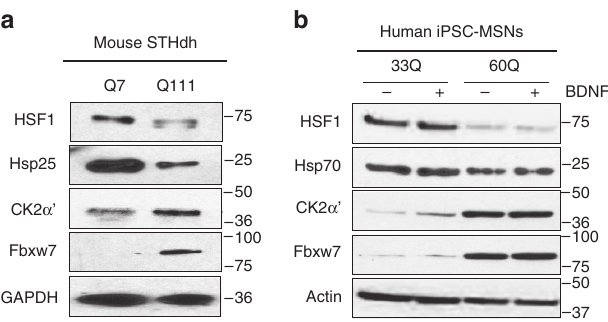
Figure 6 | Decreased abundance of HSF1 and increased levels of CK2 a 0 and Fbxw7 in mouse striatal neurons and differentiated human iPSCs expressing polyQ-expanded Htt. ( a ) Mouse STHdh Q7 and Q111 cells were cultured at 33 (cid:2) C for 48h. ( b ) Human iPSC from 33Q (Control) and 60Q (HD) individuals were differentiated into MSNs for 54 days as previously described 65,66 , and transferred to minimal differentiation medium with ( þ ) or without ( (cid:2) ) BDNF for 48h. Protein samples were immunoblotted for the indicated proteins. See Supplementary Fig. 12 for uncropped